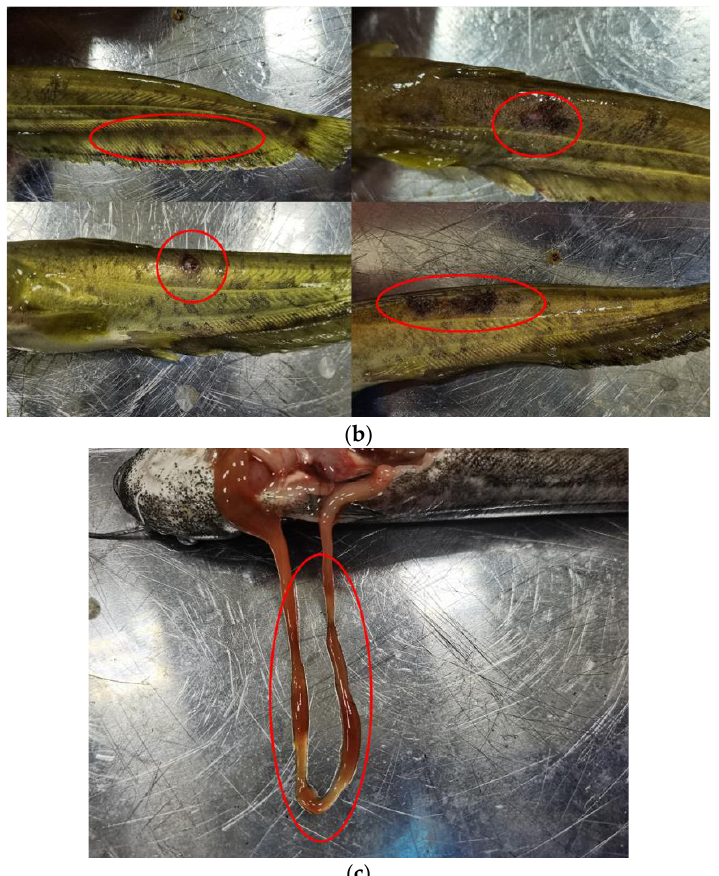
Figure 1. Body surface symptoms of southern catfish infected with Plesiomonas shigelloides for 72 h. ( a ) Bleeding of anal fin of southern catfish infected with Plesiomonas shigelloides in PS vs. L-PS group. A: Southern catfish in L-PS group; B: southern catfish in PS groups. ( b ) Body surface symptoms of southern catfish. ( c ) Intestinal redness and swelling of southern catfish. Table 2. Incidence of southern catfish in each group. Group Number Patients Prevalence BC 20